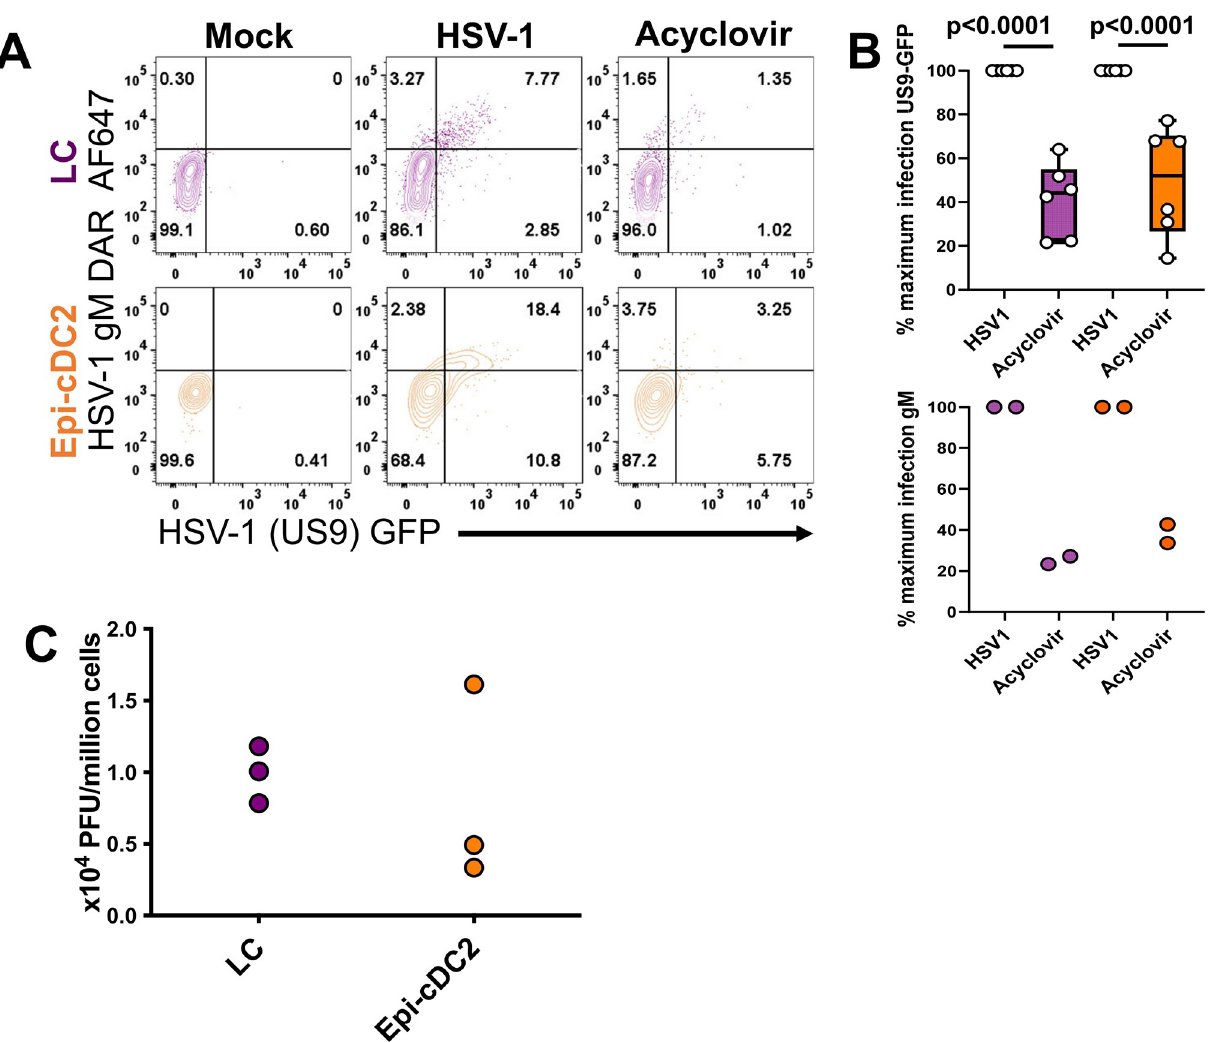
Fig 4. The expression of HSV-1(US9)-GFP and gM are significantly reduced by acyclovir, low level extracellular virus is detectable from both LCs and Epi-cDC2s. (A & B) A mixed population of epidermal MNPs was isolated from human abdominal epidermis and inoculated with HSV-1 GFP (MOI of 10) or mock treated for 1 h, then washed and resuspended in HaCaT-conditioned medium. HSV-1 GFP inoculated cells were split into two tubes, acyclovir (500 μ g/ mL) was added to one tube and all cells were incubated for a total infection time of 18 h at 37˚C. The cells were then washed with PBS and labelled for flow cytometry as in Fig 2. Additionally, cells were permeabilized then followed by serial intracellular labelling with rabbit anti- HSV-1 gM then donkey-anti-rabbit AF647. The percentage of HSV-1 (US9)-GFP + and gM AF647 + cells was analysed for each subset at 18 h, with gates set according to the mock condition as shown in the (A) representative plot. (B) HSV-1 infected cells were set as 100% infection and the data are shown as box and whisker plots of the percentage of maximum infection in LCs (purple) and Epi-cDC2s (orange). Repeated measures one-way ANOVA with Tukey’s test for multiple pairwise comparisons was used to compare the percentage of maximum infection of each subset in the presence of acyclovir, HSV-1 (US9)-GFP n = 6, gM n = 2. (C) Mixed epidermal MNPs were isolated from human abdominal epidermis and FACS sorting was performed to isolate each subset. LCs and Epi-cDC2s were separately inoculated with HSV-1 GFP (MOI of 10) for 1 h, then washed, resuspended at 7x10 3 cells per 100 μ L and incubated for a total infection time of 24 h in HaCaT-conditioned medium at 37˚C. Supernatants were collected and a fluorescent plaque assay was performed. Data shows the plaque counts of supernatants of HSV-1 infected LCs (purple) and Epi-cDC2s (orange) with PFU normalized to per million cells, n =